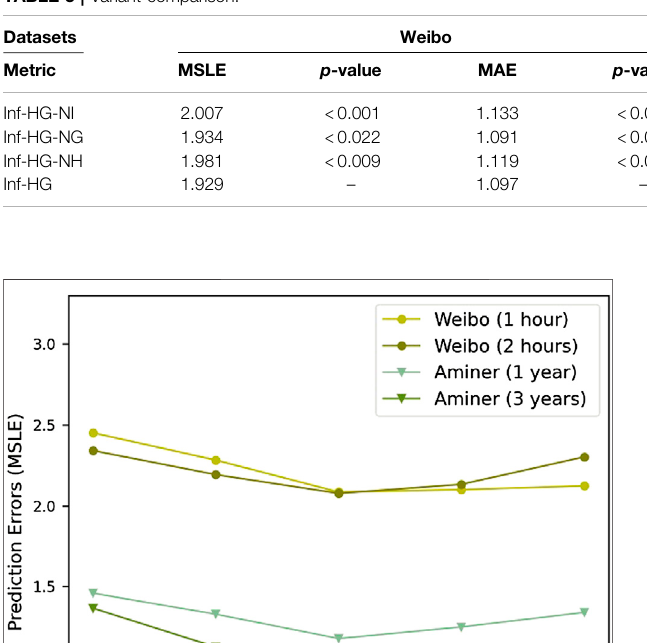
TABLE 3 | Variant comparison.